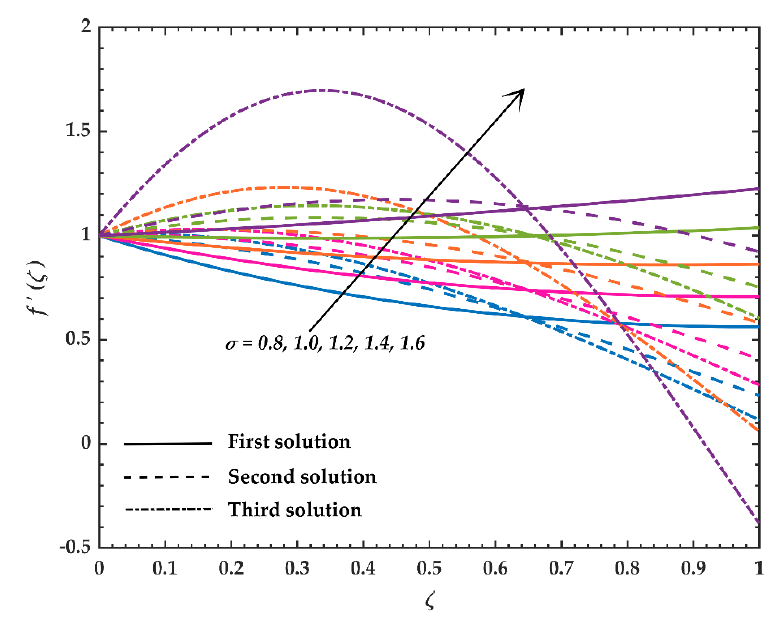
Figure 2. Velocity profiles, f (cid:48) ( ζ ) when Pr = 30, We = 0.2, n = 0.6, S = − 0.3, and M = 2 as σ varies. Table 3. Value of J as σ varies at Pr = 30, We = 0.2, n = 0.6, S = − 0.3 and M = 2.